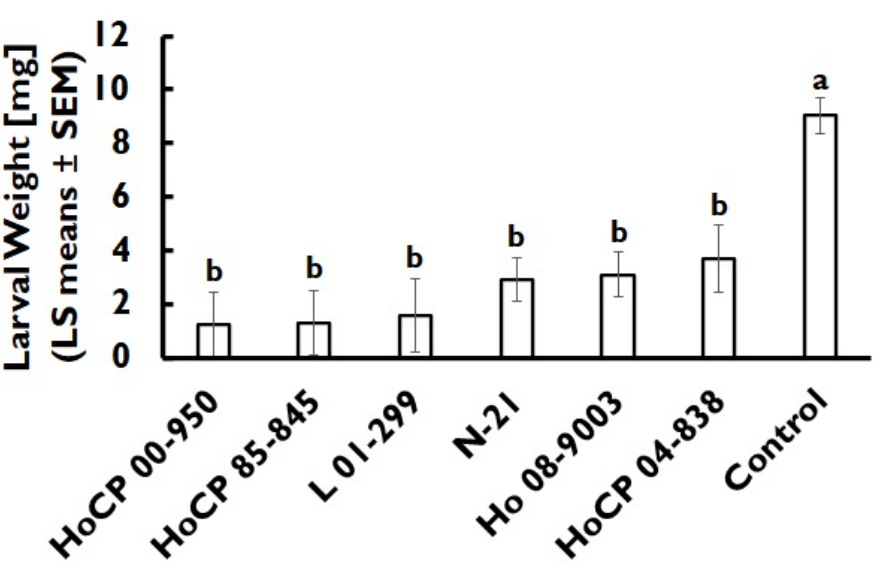
Figure 3. Eoreuma loftini larval weight as influenced by cultivar in diet incorporation assay. Bars that share a letter are not significantly different (Tukey–Kramer HSD, α = 0.05).